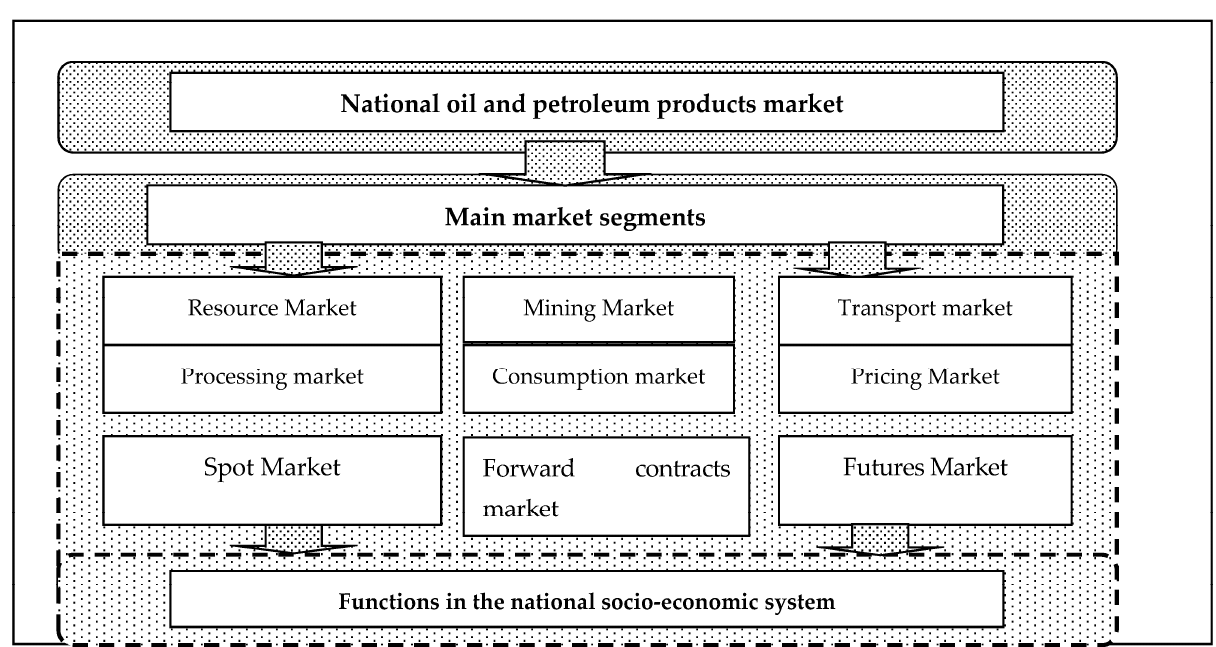
Table 2. Dynamics of oil production by the leading countries of the world and the share in world production for 2015–2021, million tons (Compiled according to the “Statistical Review of World En- ergy 2022”, British PetroleumBp Statistical Review of World Energy/2022 p. 16 [Electronic resource]. Access mode: https://www.bp.com/content/dam/bp/business-sites/en/global/corporate/pdf/energy- economics/statistical-review/bp-statsreview-2022-full-report.pdf, accessed on 20 October 2022.